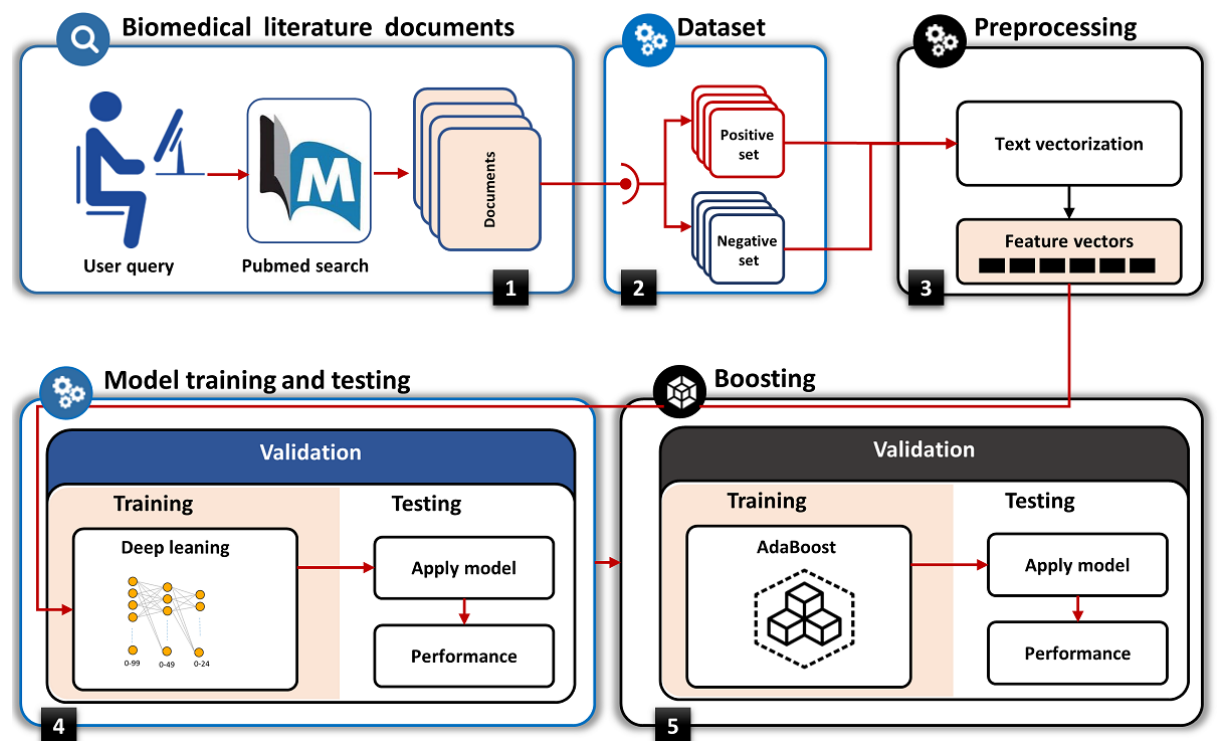
Figure 2. Process steps of proposed prognosis quality recognition (PQR) model training and